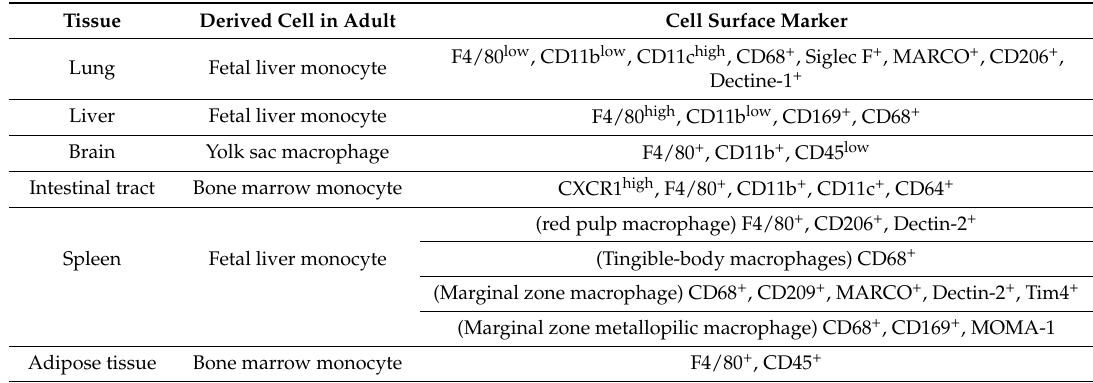
Table 1. Origin of tissue macrophages and cell surface